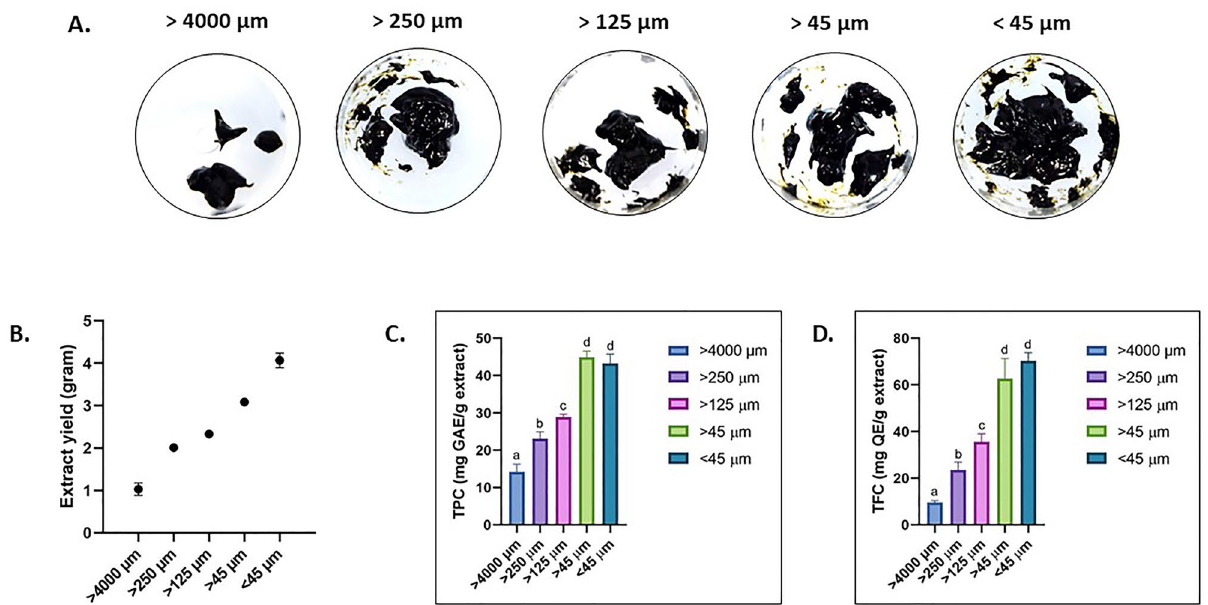
Figure 2. Effect of particle size on S.cristaefolium extract ( A ) total yield, ( B ) yield increase, ( C ) TPC-Total Phenolic Content, and ( D ) TFC-Total Flavonoid Content. Different letters indicating significant difference ( p <